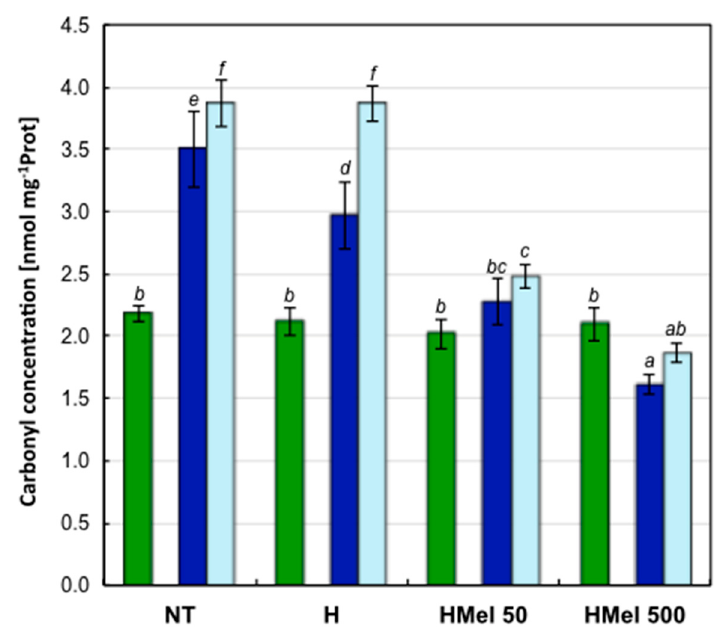
Figure 5. Effect of different maize seed hydropriming treatments on protein oxidation expressed as carbonyl group concentration in the axes isolated from non-treated seeds (NT), and those from hydroprimed with water (H) and with melatonin water solutions in concentrations: 50 μ M (HMel 50) and 500 μ M (HMel 500). The seeds were imbibed/germinated in water at 5 °C in darkness for 14 days (S [ ■ ]—chilling stress), and subsequently regenerated at 25 °C for 1 day (R [ ■ ]—regeneration). Proteins and its oxidation were also estimated in axes isolated from the seeds germinated for 24 h under optimal conditions 25 °C (C [ ■ ]—optimum, control conditions). The results are expressed as means of 6–9 measurements ± SEM. Two-way ANOVA and Duncan’s post-hoc tests were performed. The lowercase letters next to the values show statistical significance at the specified p .